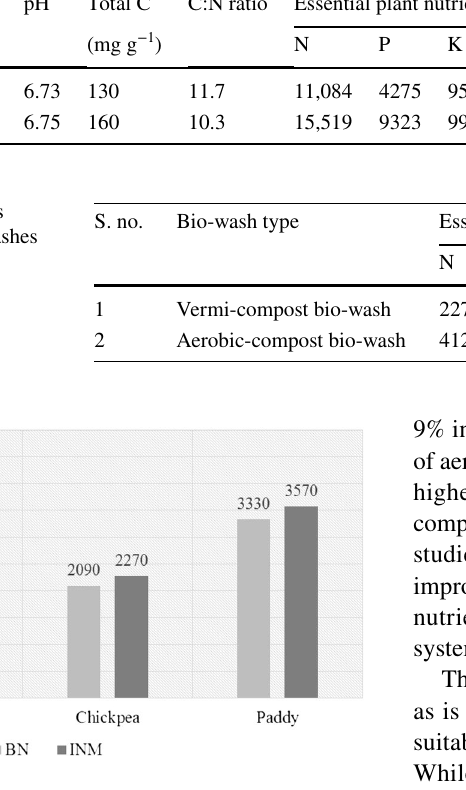
Fig. 4 Effects of soil test-based balanced (BN) and integrated (INM) nutrient management in India—vermi-compost in wheat and chickpea crops in Sagar district, aerobic-compost in paddy in Kadapa district (LSD 5% = 162 in wheat, 37.2 in chickpea and 29.9 in